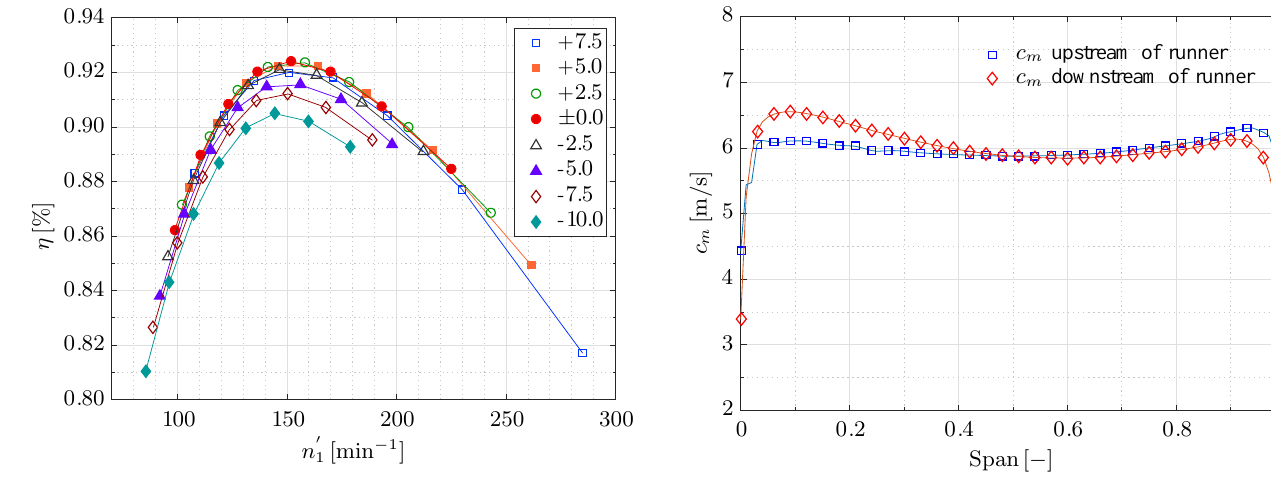
tion downstream of the runner. The flow is diverted somewhat towards the hub with a maximum of c m = 6 . 5 m / s at a span of 0.1. Generally, the flow velocities are slightly higher at this location. This is attributed to continuity, as the cross section of the turbine decreases slightly from upstream to downstream. 4) Swirl distribution: The outlet swirl distribution is strongly dependent on the runner speed and therefore on the operating point. The distribution of r c u is depicted in · Figure 10 for the rated operating point. Upstream of the runner, the distribution has a linear gradient from hub to shroud. As the flow progresses through the runner, it performs mechanical work on the runner blades and the hydraulic head is reduced. This reduction is reflected in the drop of r c u from upstream · to downstream of the runner. As anticipated, the swirl near the hub is slightly negative and zero at a span of 0.2. Directly at the hub, the swirl increases, which is induced by the rotating